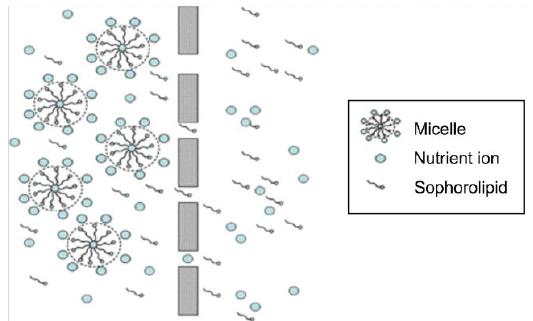
Figure 1. Schematic diagram of micellar-enhanced ultrafiltration.